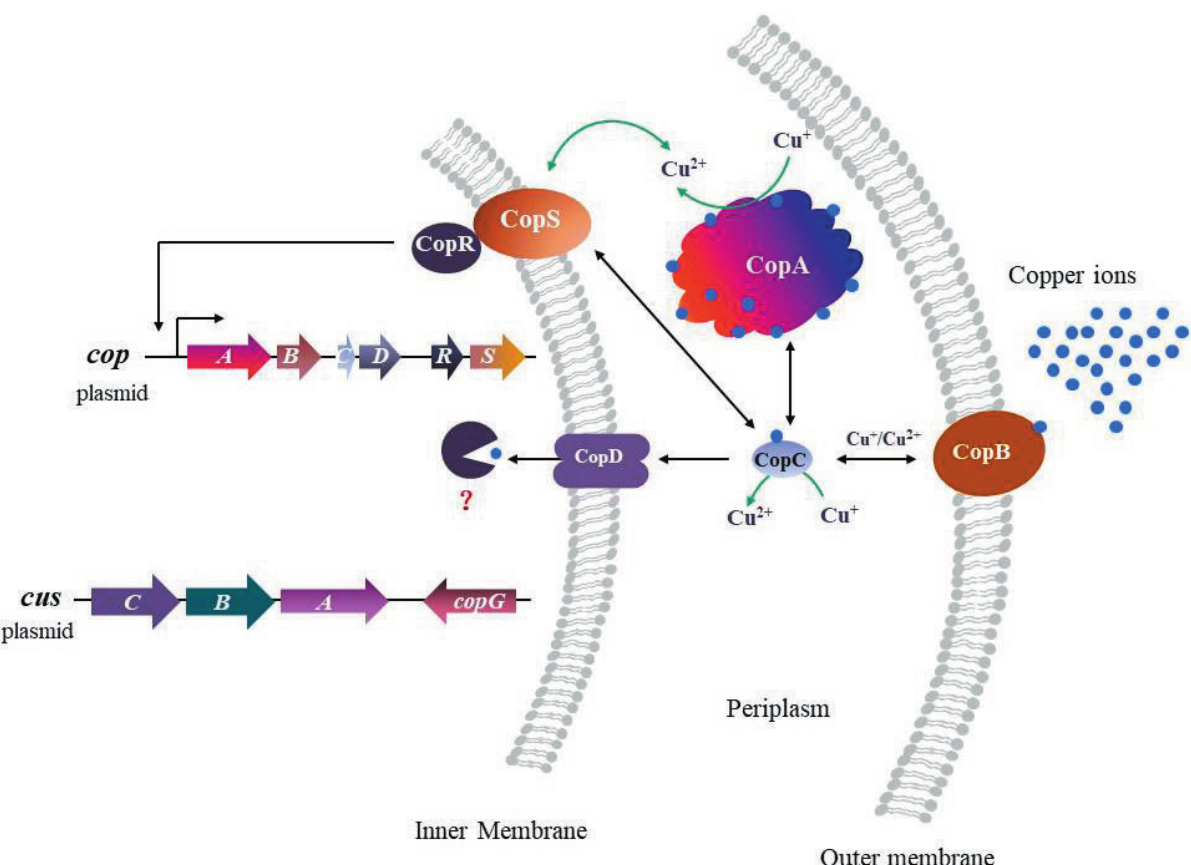
Figure. 1. Proposed model of encoded proteins involved in copper resistance in Pseudomonas syringae . Arrows indicate interactions between proteins. CopR induces the expression of copABCD via CopS which detects excess periplasmic copper. CopA sequesters excess periplasmic copper due to its strong binding ability; CopB combines with copper; CopC transfers copper from CopA to CopD, and CopD then transports copper into bacterium cytoplasm. CopC also functions as a redox switch to maintain free copper ion concentrations in solu- tion at sub-picomolar levels. The structure of the cus operon and copG in plasmids of P. syringae pv. syringae is a novel efflux system, but the location of these proteins in cell has not been